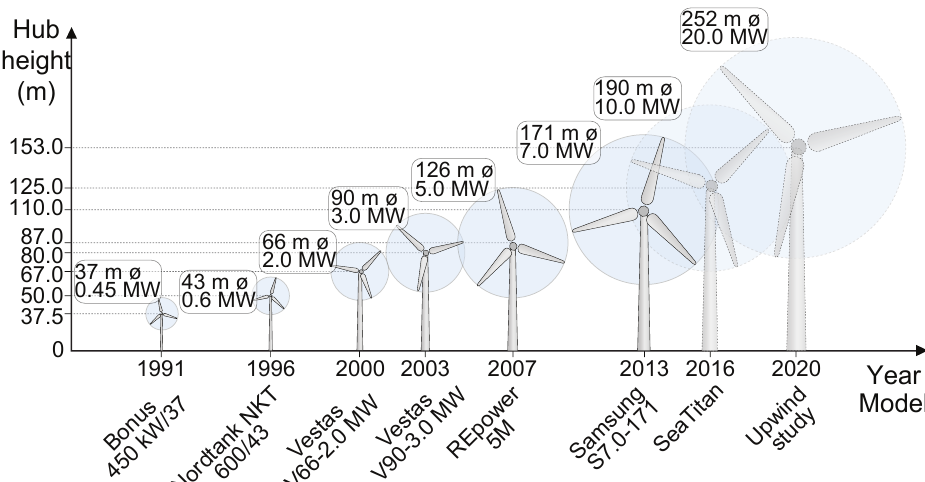
Figure 7. Hub height, rated power and rotor diameter of several wind turbine models and their commission year [10,11].